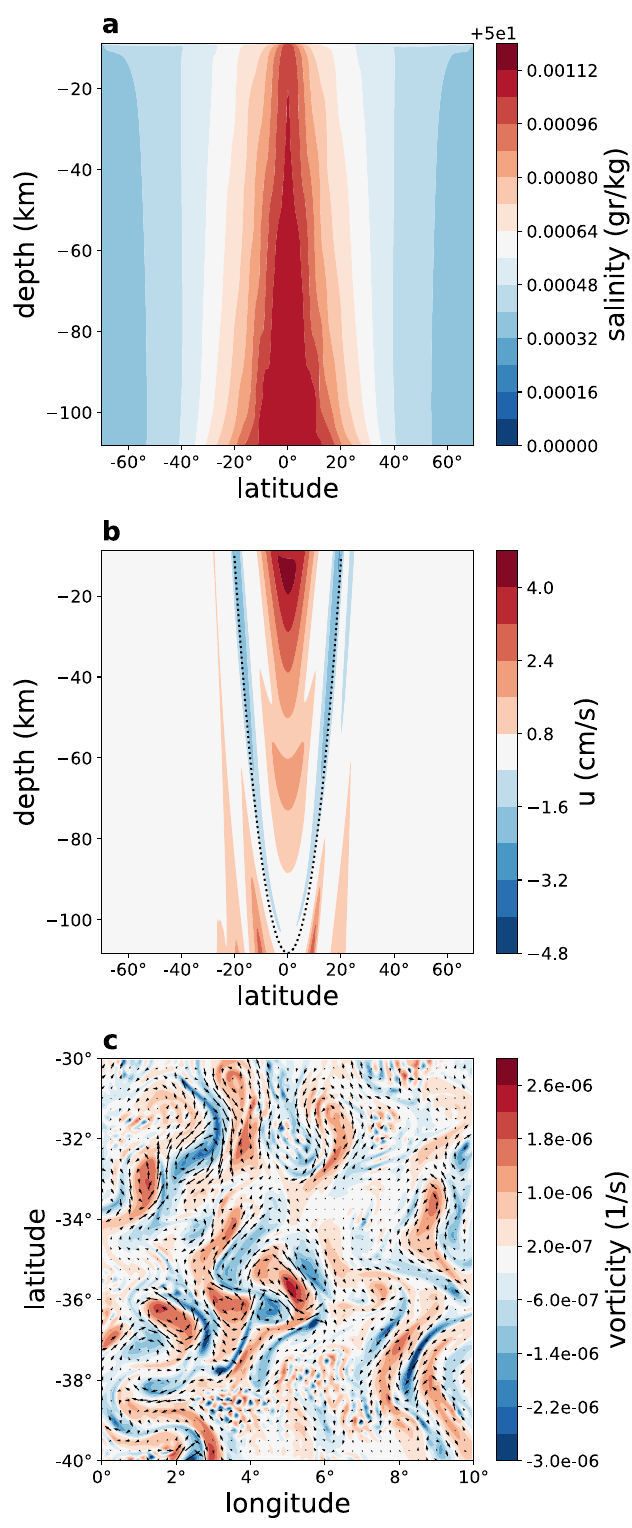
Fig. 5 Results of the 3d simulation — salinity, zonal velocity, and vorticity. a , b Latitude-depth plots of zonal mean salinity (g/kg) and zonal velocity (cm s − 1 ). c Vorticity (s − 1 ) and velocity fi eld (arrows) at the ocean surface, as a function of longitude and latitude, demonstrating the rotational fl uid velocity around the Taylor